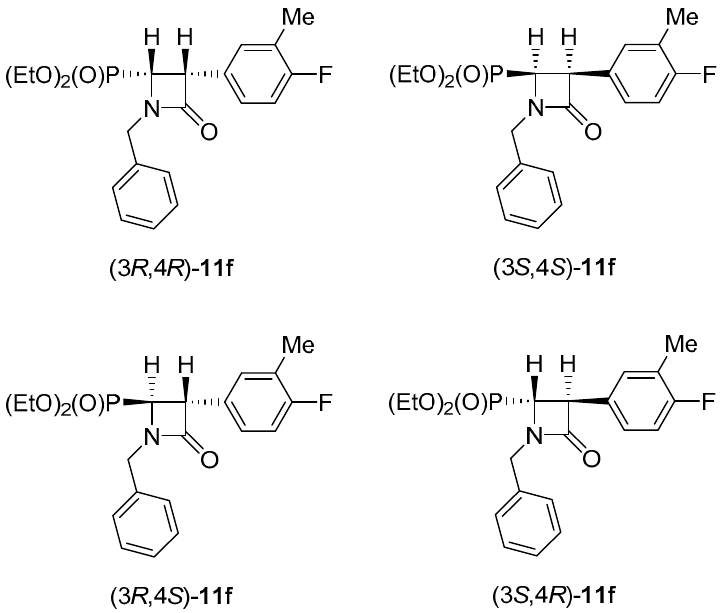
Figure 4. Four stereoisomers of 11f explored in silico.